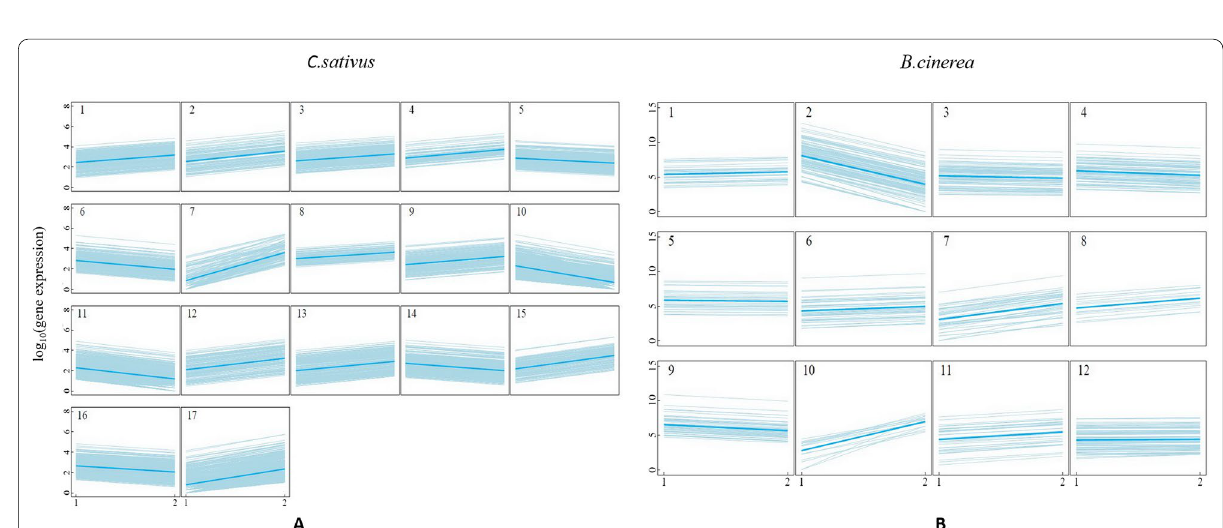
Fig. 2 Differentiation patterns of genes from distinct groups. A There are 17 groups expressed in c. sativus ; B there are 12 groups expressed in B. cinerea. In each group, the mean expression curve is indicated by a thick line over expressions curves of individual genes (thin